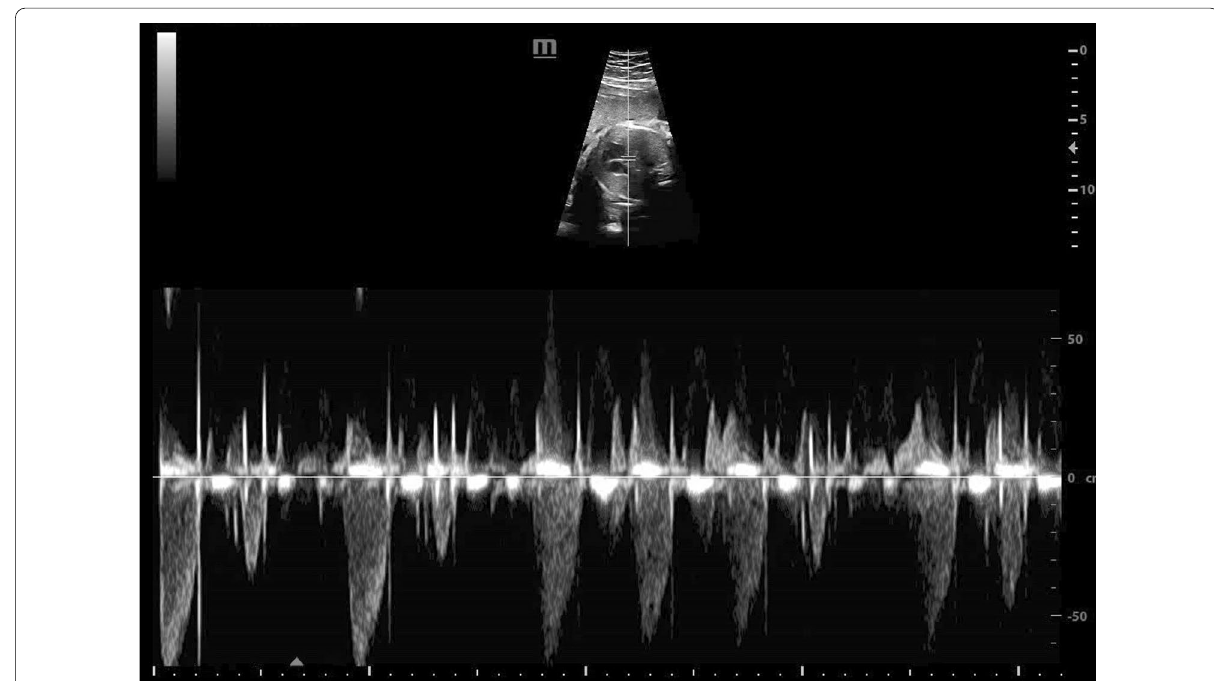
Fig. 1 The pulsed Doppler sample gate was placed to include the outflow and inflow of the left ventricle. It shows the occurrence of frequent premature ventricular contractions (PVCs) with the full compensatory pauses and the first part being in a bigeminy pattern